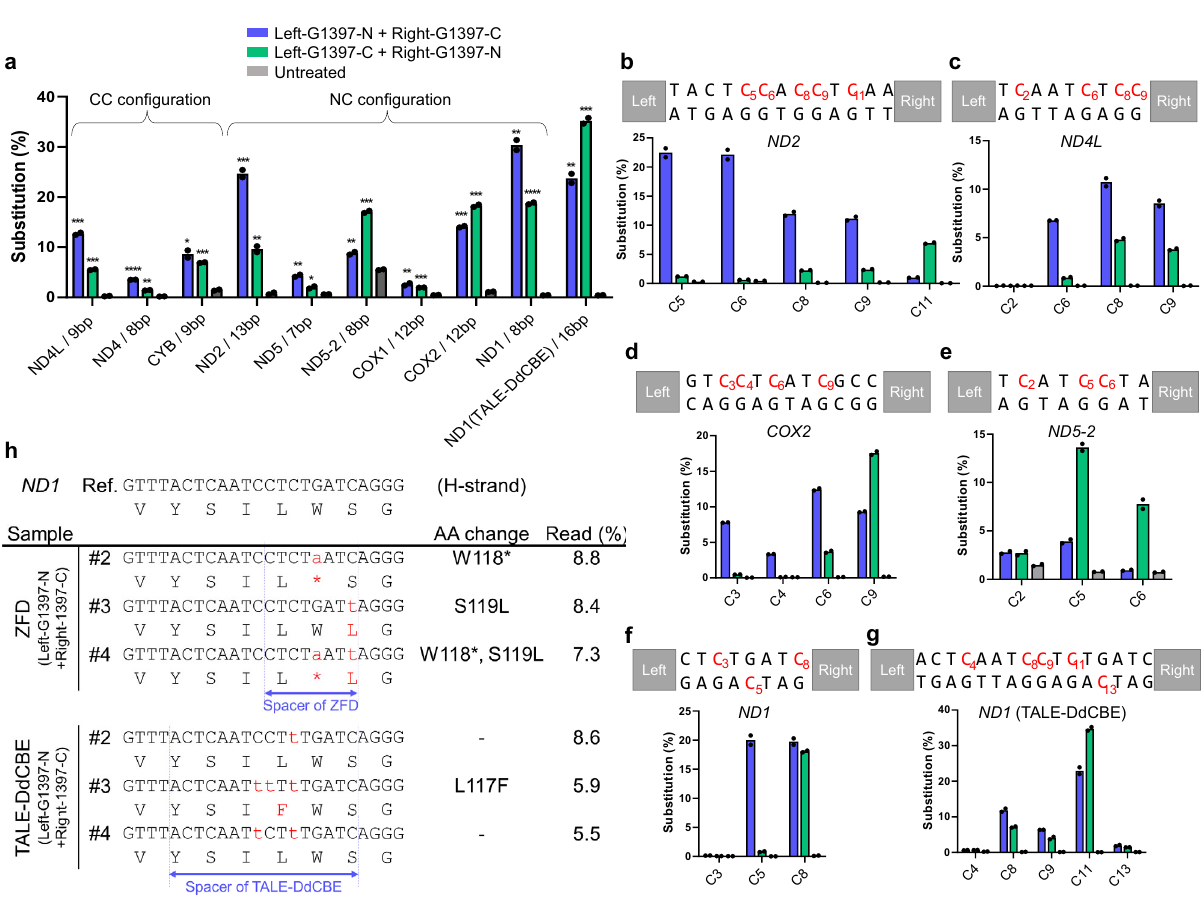
Fig. 3 mtDNA editing with mitoZFDs. a Base editing frequencies in mtDNA induced by mitoZFDs and a TALE-DdCBE in HEK 293 T cells. All statistical analysis for comparing with untreated samples was conducted using unpaired Student ’ s t -test (two-tailed) in GraphPad Prism 8. Statistical signi fi cance as compared with untreated samples was denoted with * P ≤ 0.05, ** P ≤ 0.01, *** P ≤ 0.001, **** P ≤ 0.0001, n.s. (not signi fi cant) P > 0.05. Data are shown as means from n = 2 biologically independent samples. b – g mitoZFD-induced base editing ef fi ciencies at each base position within the spacer at the ND2 ( b ), ND4L ( c ), COX2 ( d ), ND5-2 ( e ), and ND1 ( f ) target sites, and TALE-DdCBE-induced base editing ef fi ciencies at the ND1 ( g ) target site, in HEK 293 T cells. Data are shown as means from n = 2 biologically independent samples. h Comparison of DNA changes and amino acid changes in the ND1 gene introduced by mitoZFD and TALE-DdCBE. The reference sequence (Ref.) is at the top. In the alleles, the red letters indicate changes in the amino acid sequence. (* indicates a stop codon.) The frequency of sequencing reads (%) for each mutant allele was measured by targeted deep sequencing. The spacer regions for the ZFD pair and the TALE-DdCBE pair are indicated with blue dashed lines. Source data are provided as a Source Data fi